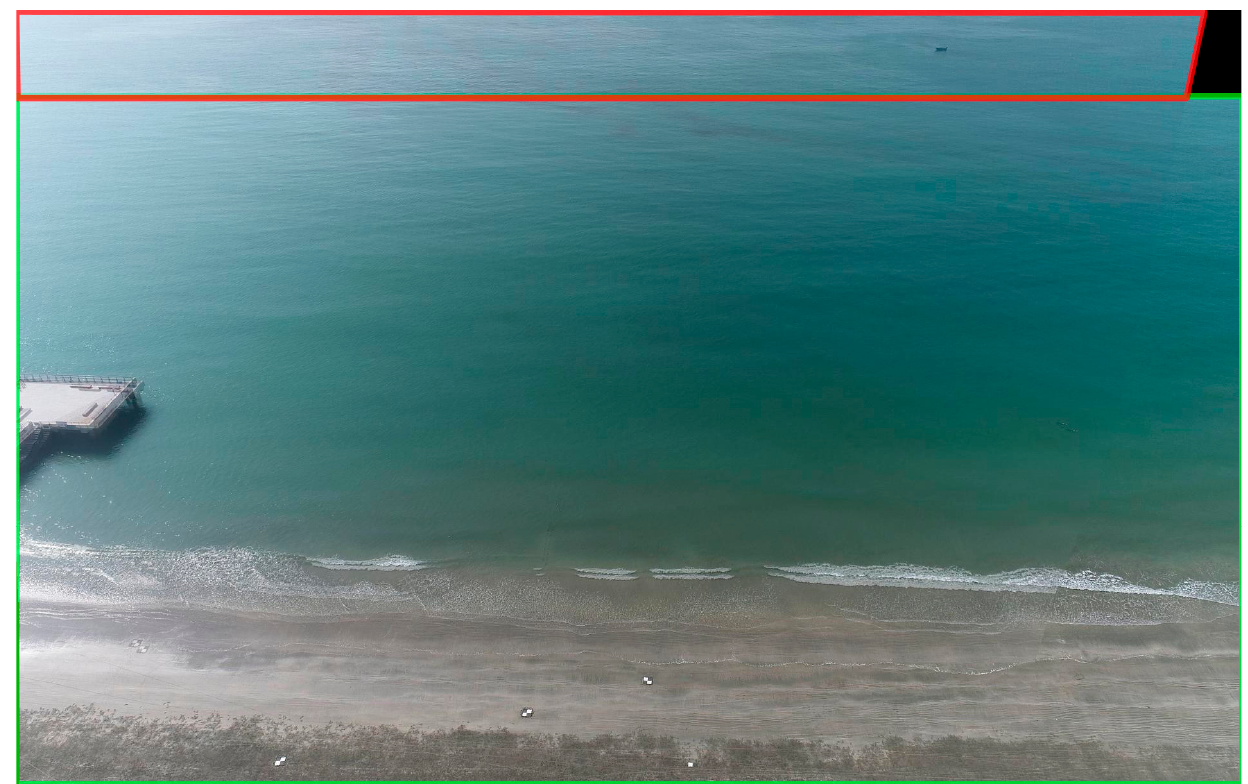
Figure 26. The result of a feature mismatch.